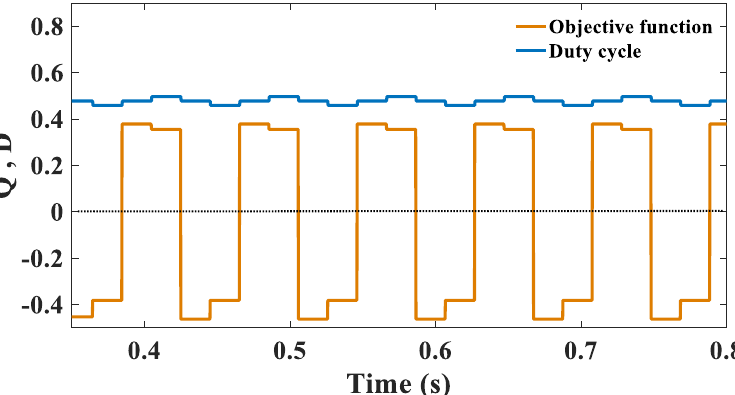
Energies 2022 , 15 , x FOR PEER REVIEW Figure 14. Zoomed portion of the oscillation of Q using the ideal model. Figure 14. Zoomed portion of the oscillation of Q using the ideal model.